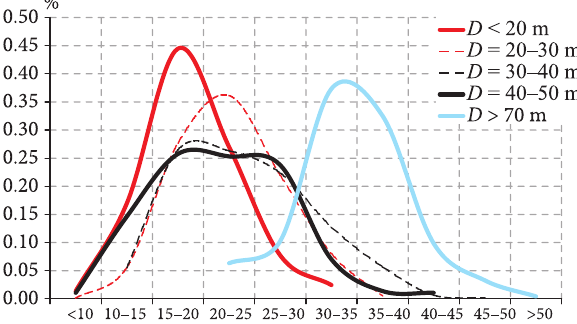
fig. 1. Speed distribution on